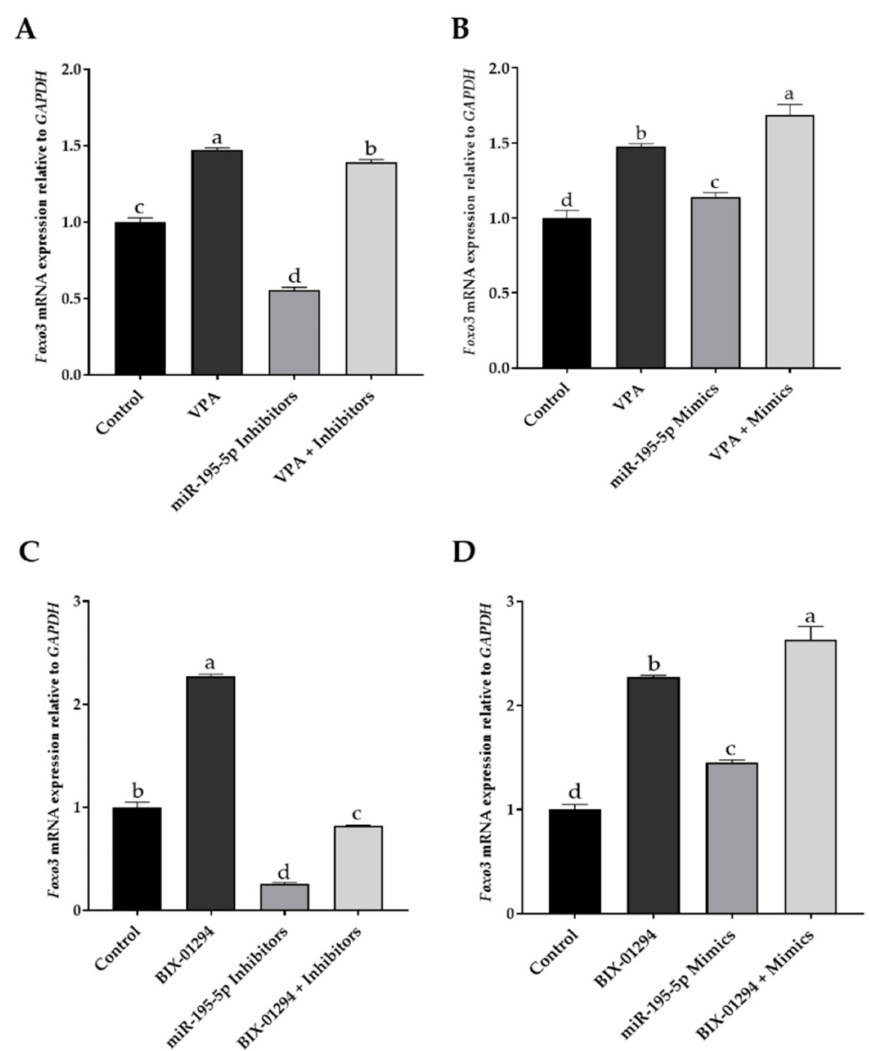
Figure 5. miR-195-5p demonstrates histone modification involved in Foxo3 expression. ( A , C ) The inhibition effect of miR-195-5p on Foxo3 expression was reversed by the specific inhibitor histone deacetylases-Valproic acid (VPA), and by the inhibitor G9a histone methyltransferase-BIX-1294, respectively. ( B , D ): The stimulating effect of miR-195-5p mimics on Foxo3 expression was enhanced by the addition of VPA and BIX-1294. Data are mean ± SEM of three independent experiments (n = 3). Means that were assigned different letters (a, b, c, d) were found to be significantly different ( p <